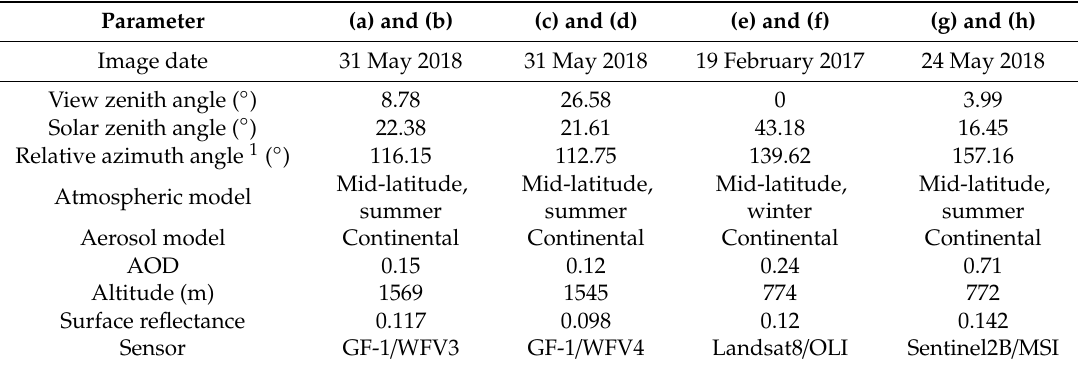
Table 4. The parameters of images in Figure 4.